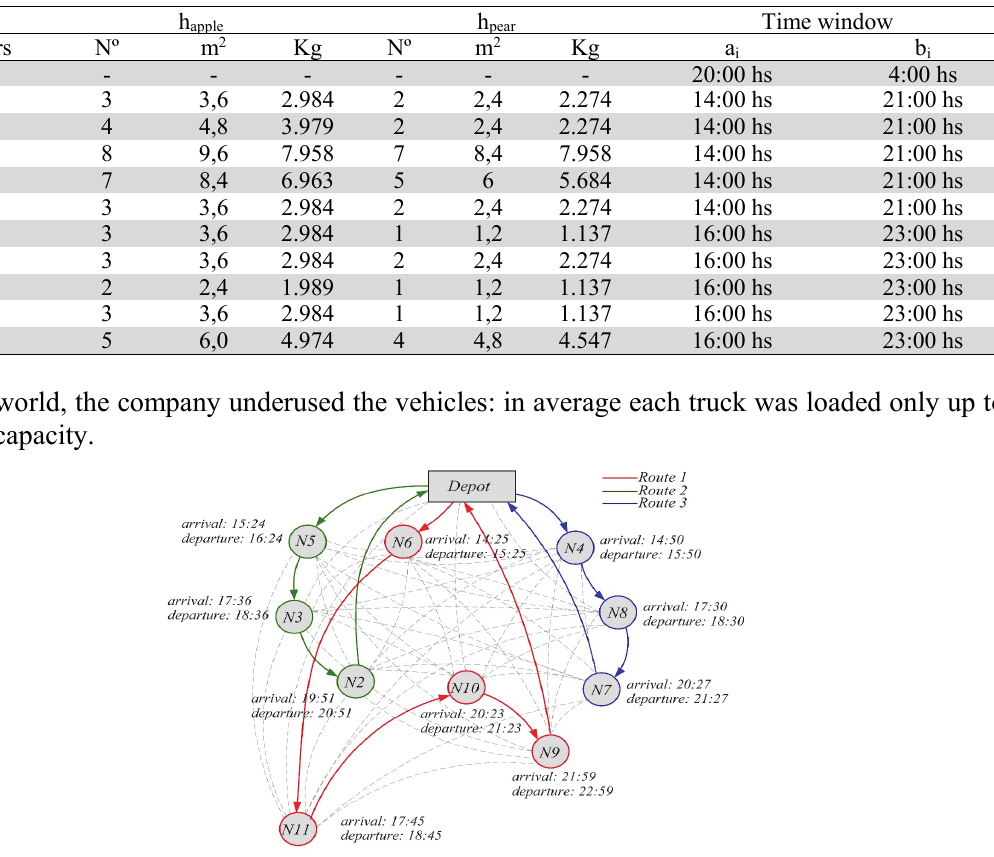
Fig. 4. Graph of the routing